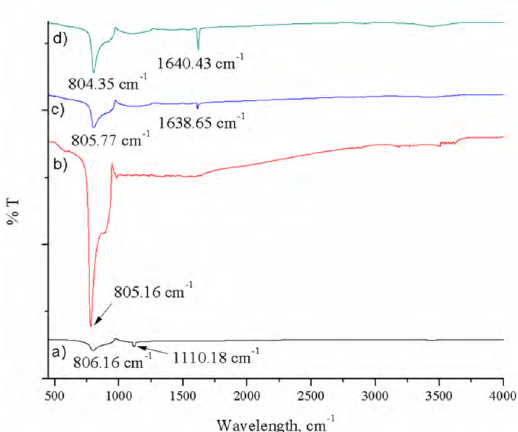
Figure 7. FTIR spectrum of SiCNTs synthesized from blend of SiO and MWCNTs in the ratio of a) 1:1; b) 1:3; c) 1:5 and d) 1:7. 2